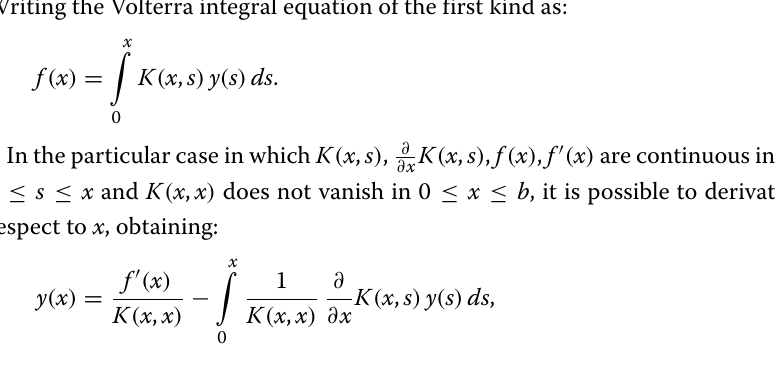
Table 1 Errors for f ( x ) = | x | with Lagrange interpolation I n 10 e n ( I